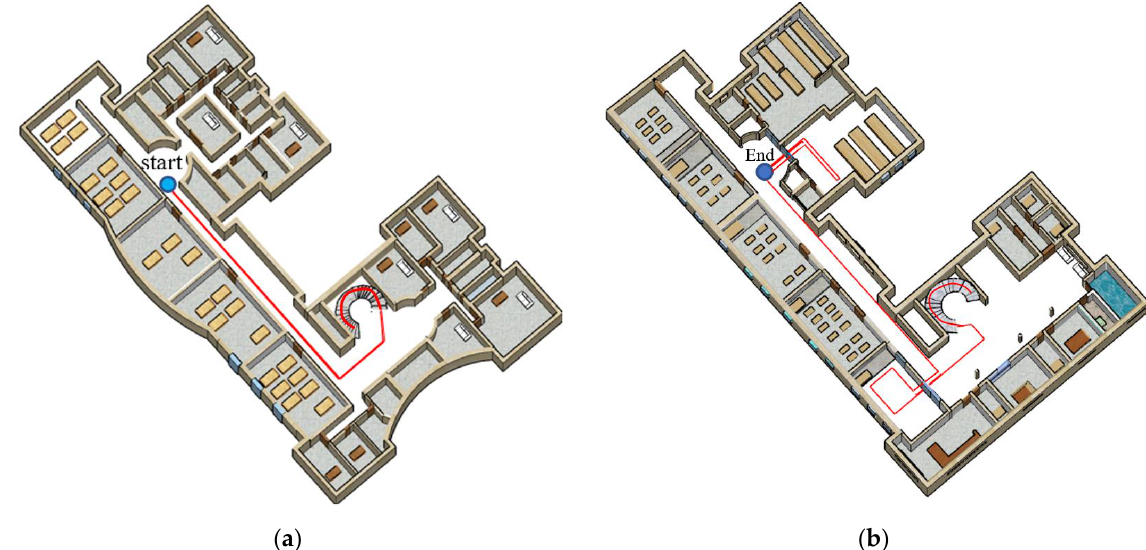
Figure 16. Designed path; ( a ) Third floor; ( b ) First floor.